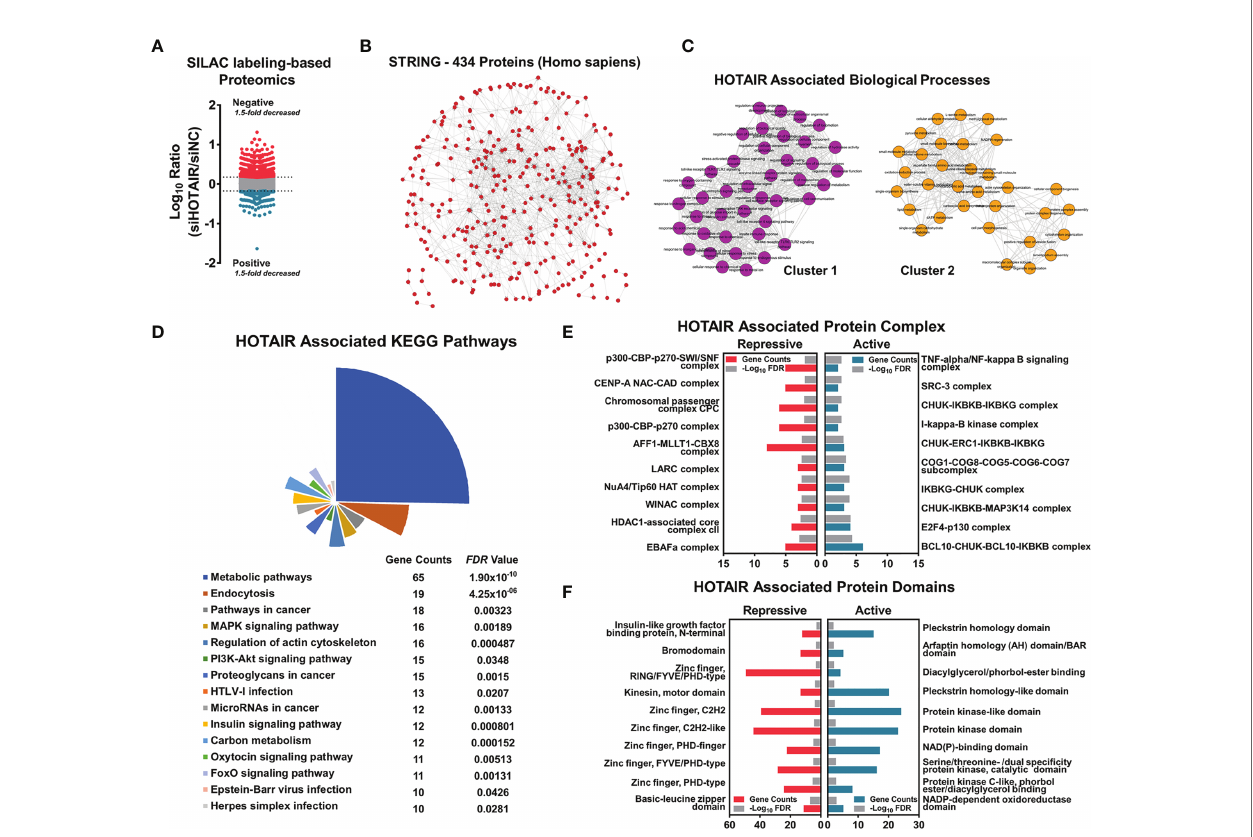
FIGURE 1 | HOTAIR regulated protein level associated with multiple biological progress, when applied to SILAC labeling-based proteome of U87 cells. (A) The scatter plot shows the number of differential proteins detected by proteome sequencing, with a difference ratio greater than 1.5. (B) STRING protein network shows that 434 proteins had high correlation. (C – F) Enrichment and clustering analysis of the quanti fi able proteomics data set including HOTAIR associated biological processes clustering (C) , KEGG pathway analysis (D) , protein complex enrichment (E) and protein domains enrichment (F)